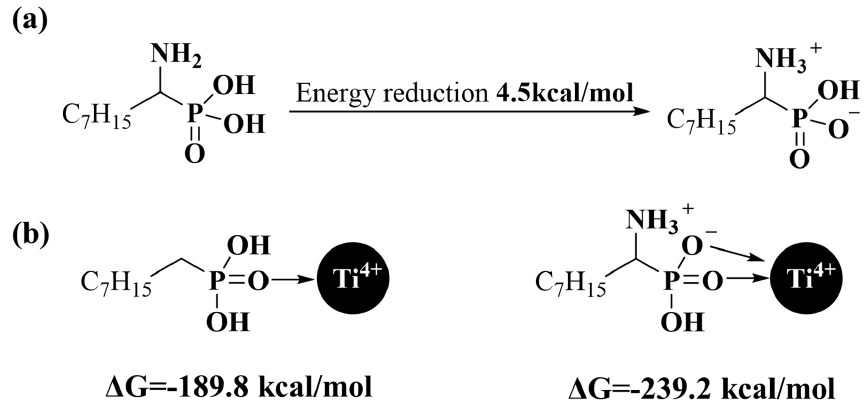
Figure 9. ( a ) Proton transfer form and energy spectrum of APA molecule; ( b ) molecular geometry and energy profile of metal ion–OPA complexes and metal ion–APA complexes in solvent.